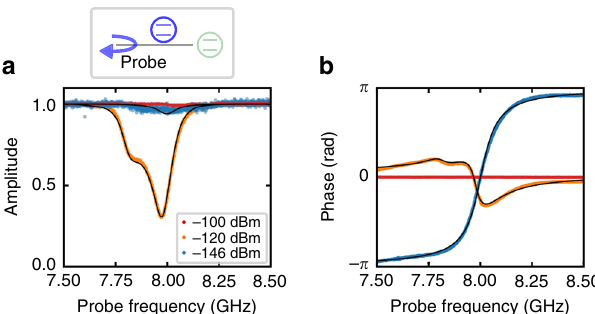
Fig. 2 Dependence of the JQF re fl ection spectrum on probe power. a , b Amplitude and phase of the re fl ection spectra of the JQF measured via the control line. The dots (blue, orange, red) are the experimental results with different probe powers, and the black lines are the theoretical fi ts for − 120 and − 146 dBm. The probe power of − 120 dBm corresponds to the single-photon power level for the JQF, de fi ned as _ ω which would populate a linear resonator with a single photon on average 30 . Note that the qubit transition is not observed here since the resolution of the probe frequency is larger than the qubit